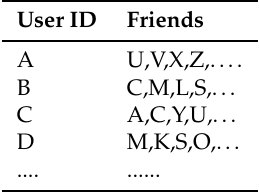
Table 7. Friends data set in key-value storage (kvs) format.